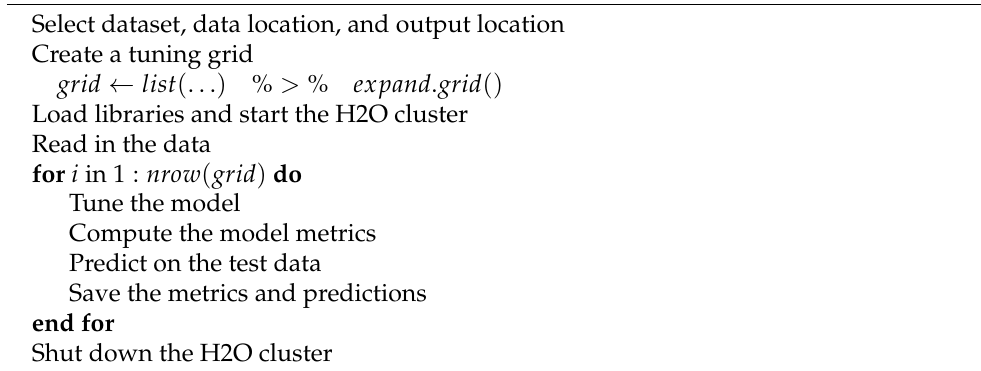
Algorithm A1 Psuedo-code for the model search performed as documented in this